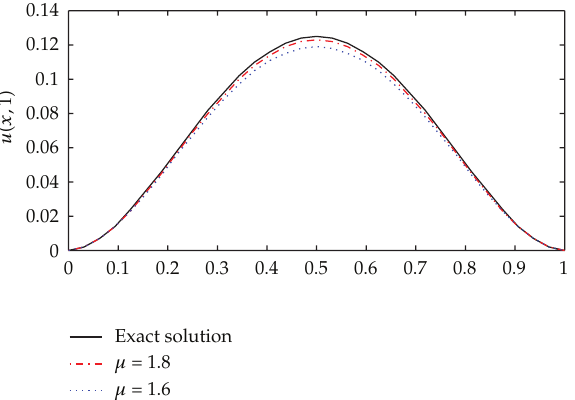
Figure 1: Exact and numerical solutions with μ (cid:8) 1 . 6 and μ (cid:8) 1 . 8.